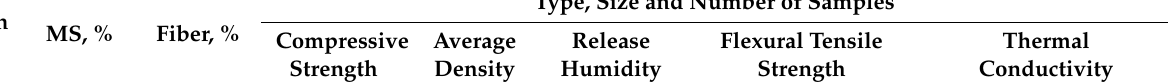
Table 5. Experimental research program.